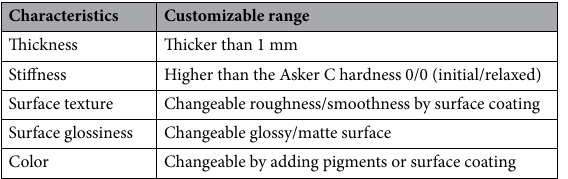
Table 4. The range of the customizable characteristics of the cover provided by Mitsui Chemicals.